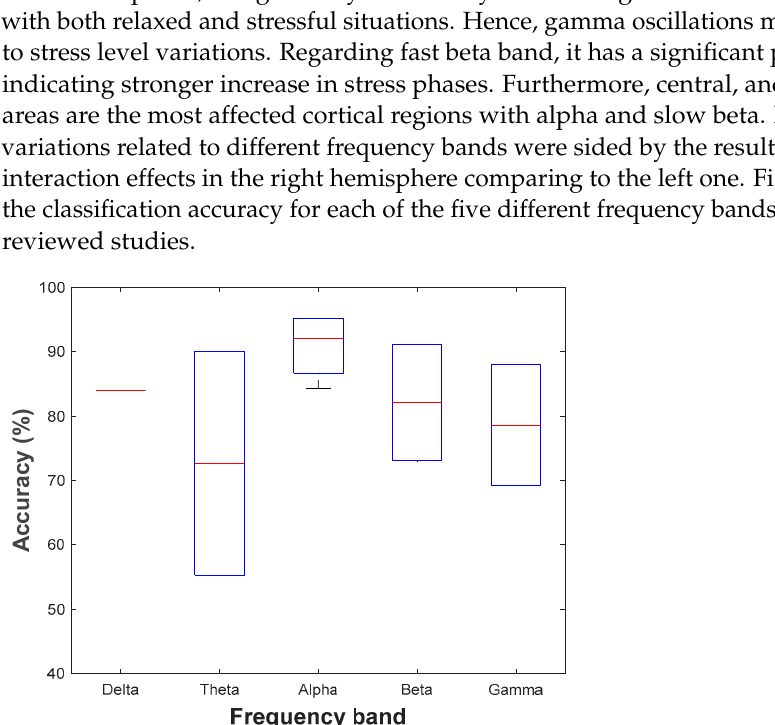
Figure 2. Classification accuracy based on EEG frequency bands.